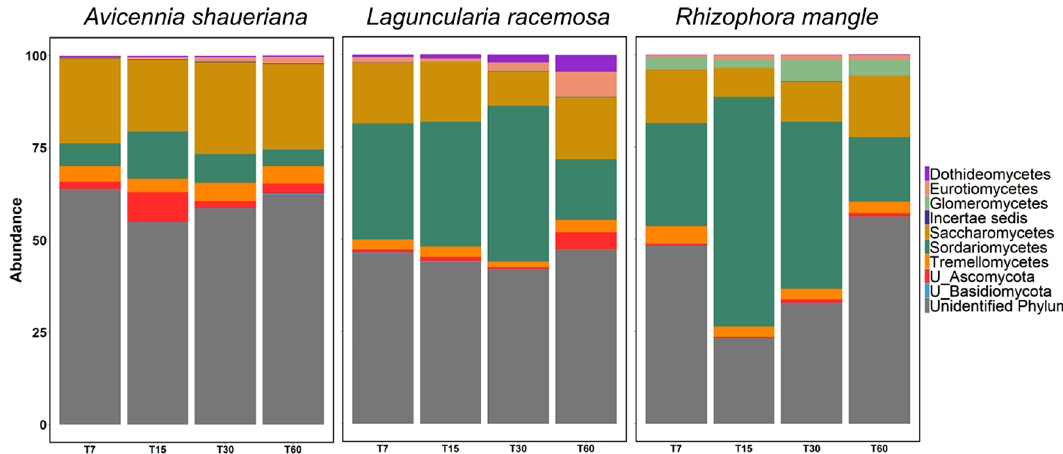
Figure 3. Relative abundance of the 10 most common classes along with the two unclassified groups (U_) belonging to the phyla Ascomycota and Basidiomycota in the A. schaueriana plant along the 60 days of decomposition